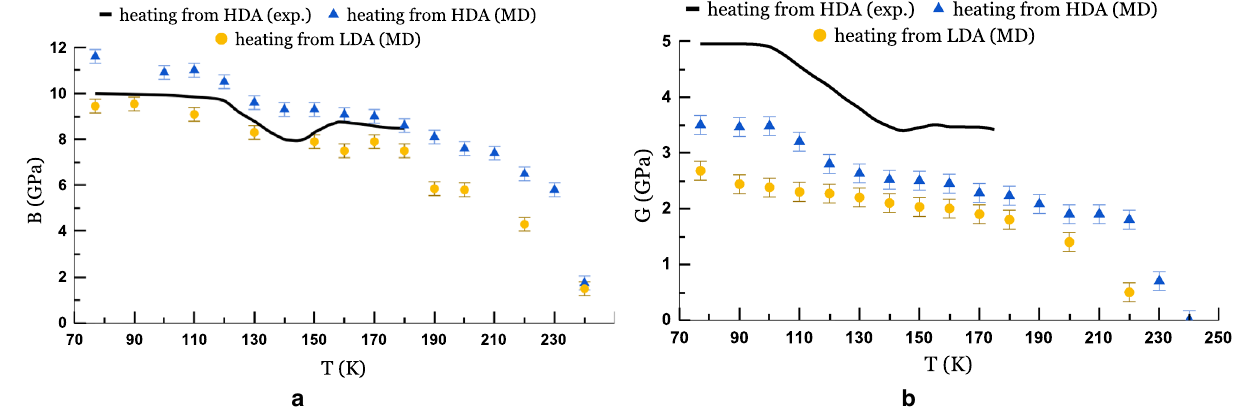
Figure 7. The temperature dependencies of ( a ) the bulk modulus and ( b ) the shear modulus during isobaric heating ( P = 0.05GPa